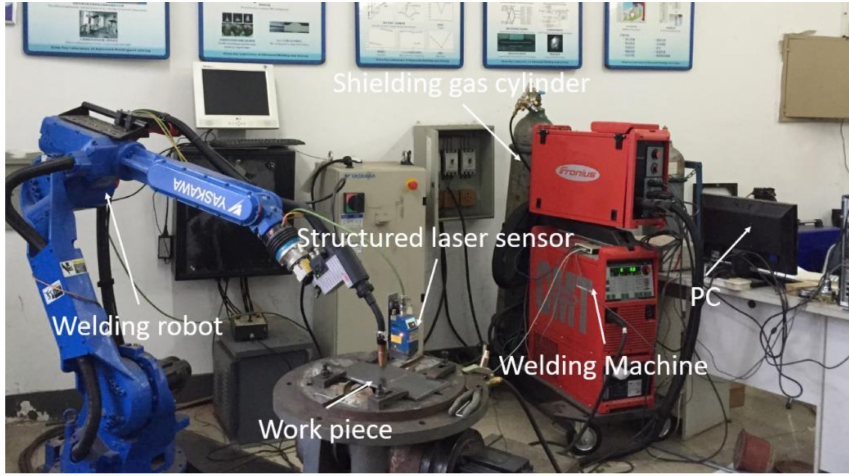
Figure 1. Experiment system.